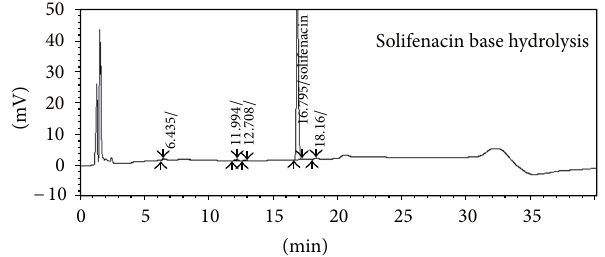
F 7: Typical HPLC chromatogram of 0.1NNaOH stressed solution.